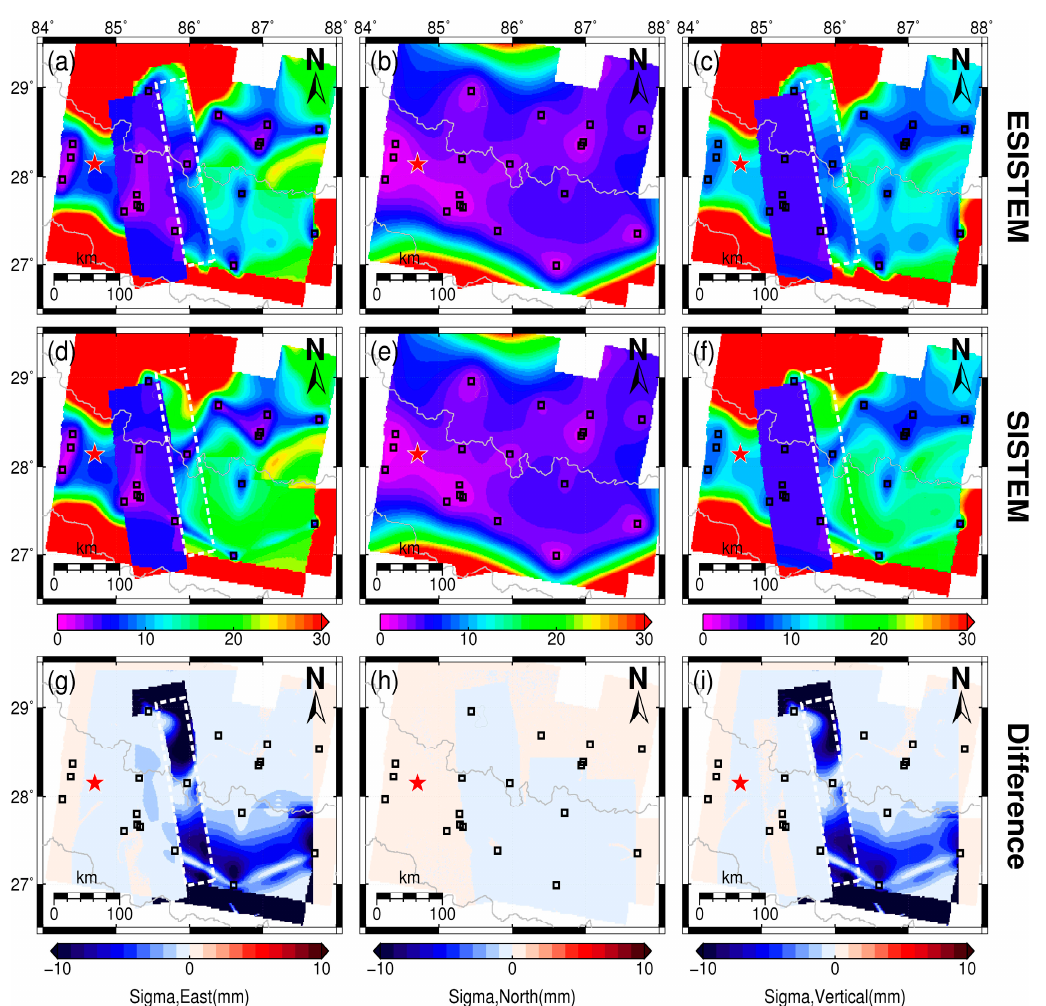
Figure 5. Standard deviations of the derived displacement fields associated with the Gorkha earthquake: ( a – c ) standard deviations using ESISTEM approach, for east, north and vertical components, respectively; ( d – f ) standard deviations using SISTEM approach, where the white dashed rectangle marks the region where standard deviations for ESISTEM are smaller than that for SISTEM approach; and ( g – i ) the differences between standard deviations using ESISTEM and SISTEM approaches (i.e., the ESISTEM-derived minus the SISTEM-derived). Squares represent horizontal GPS stations.